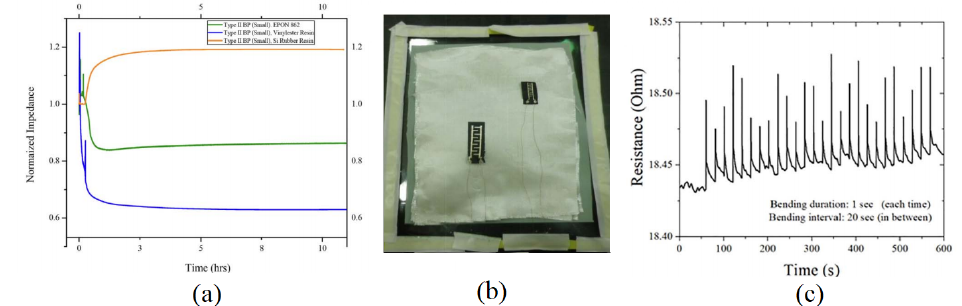
Figure 5. ( a ) Normalized impedance over time for vacuum and curing cycles for three types of resin; ( b ) Printed strain sensor placed on glass fiber reinforced composite; ( c ) Results of impact hammer bending of glass fiber reinforced composite with embedded printed strain sensor. (Reprinted from [62] under CC BY-NC-ND 4.0